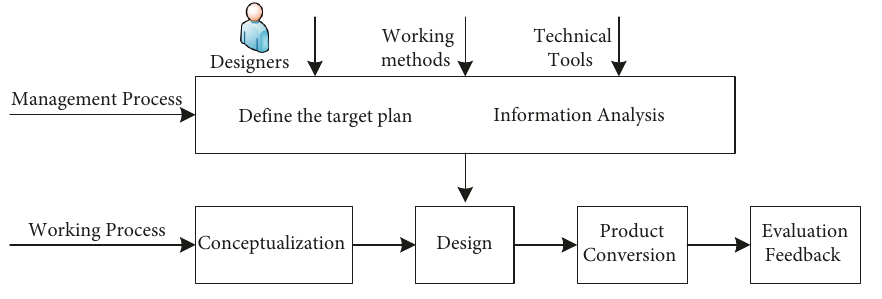
Figure 1: Garment pattern design general